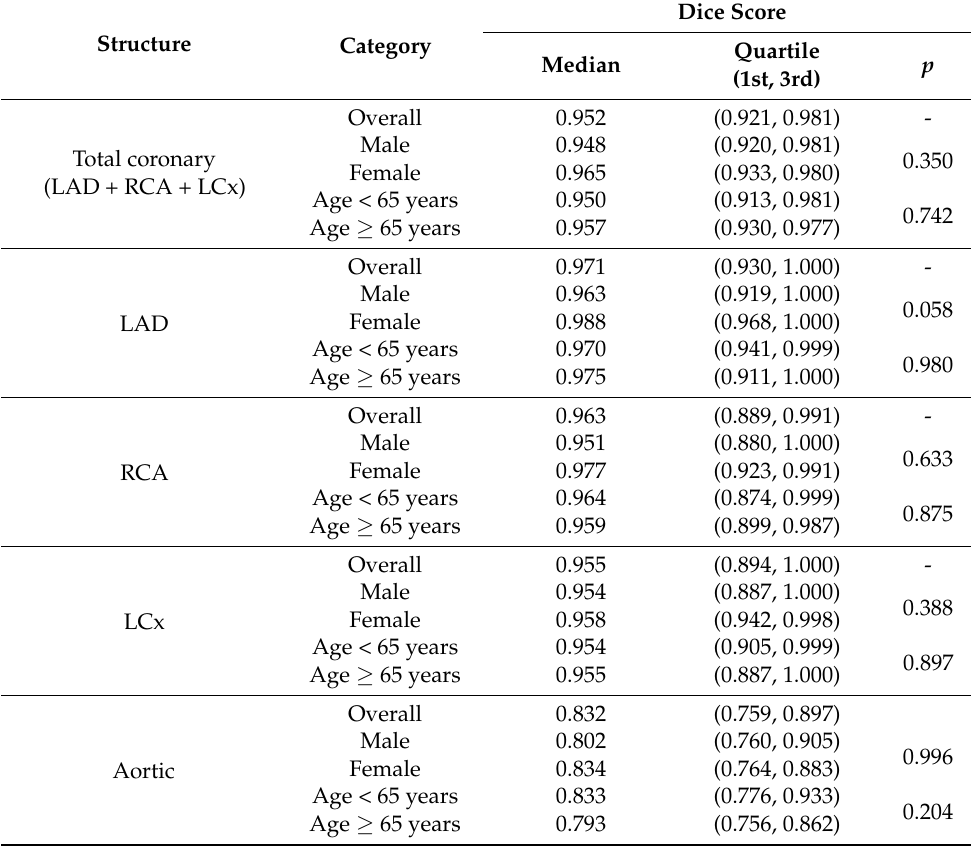
Figure 5. Correlation. Linear regression plots for the differences and agreement between deep learn- ing predicted Agatston scores and the ground truth manually annotated scores for ( A ) total cardiac calcium, ( B ) coronary artery calcium, and ( C ) aortic calcium.